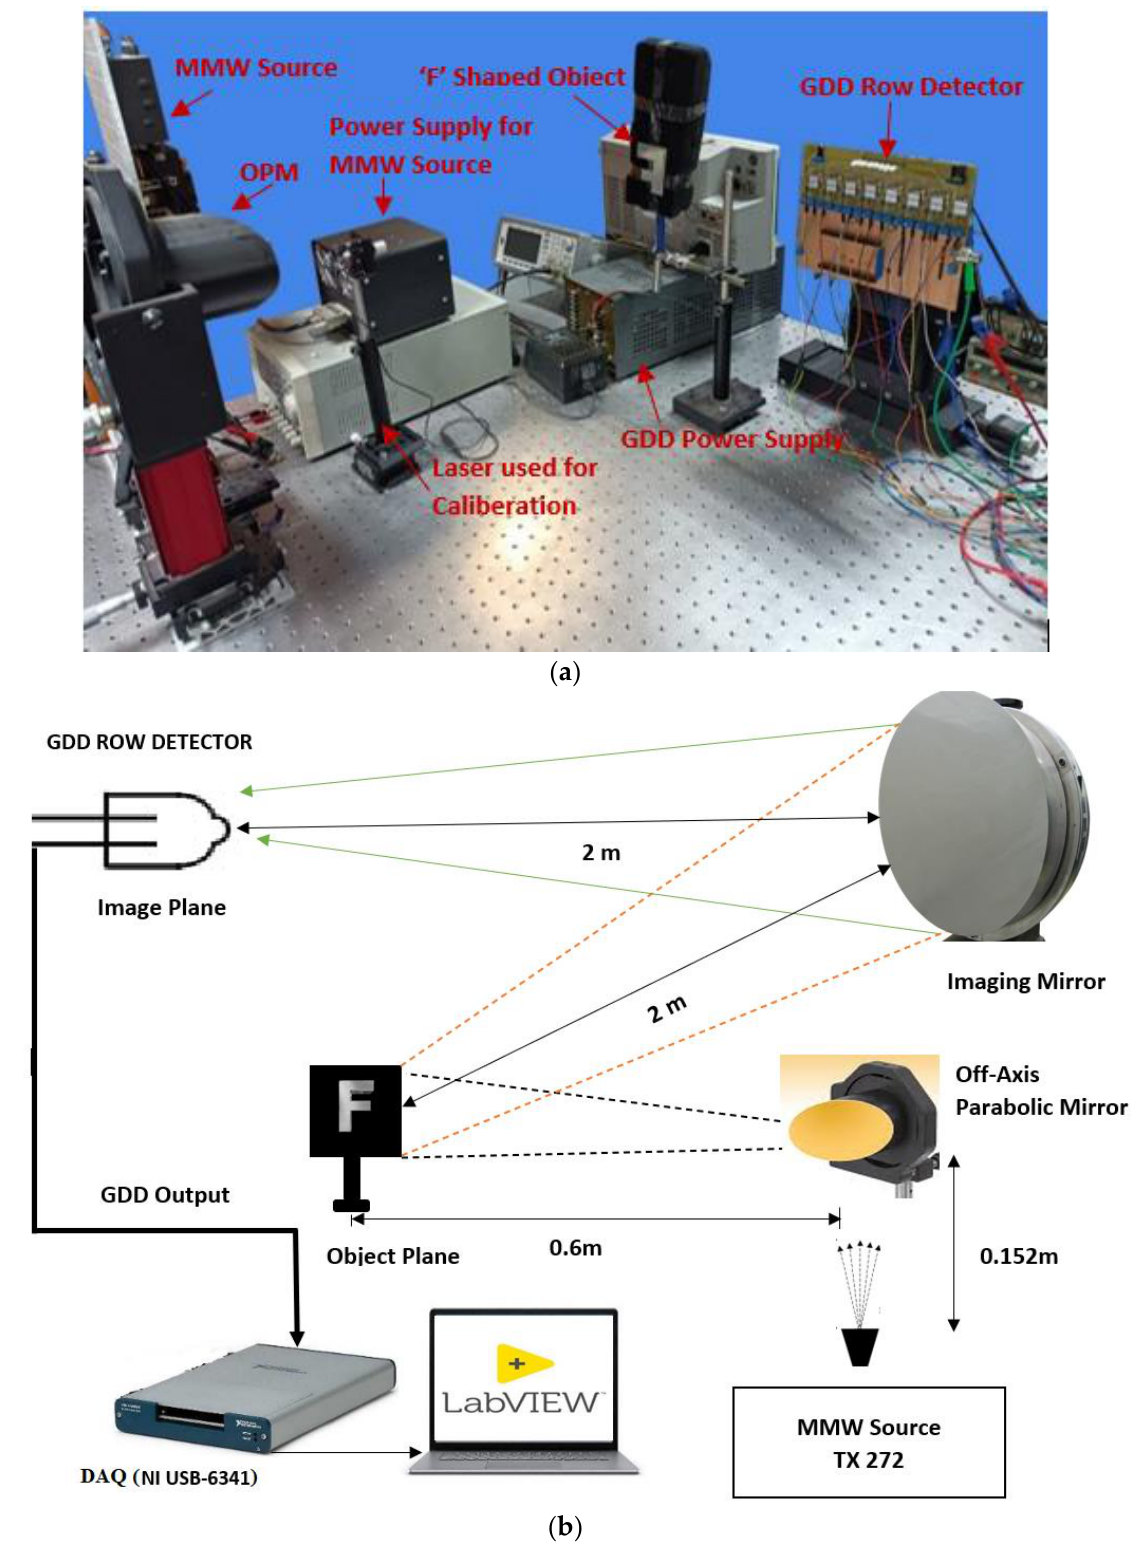
Figure 1. ( a ) Experimental setup of the MMW imaging system and ( b ) a schematic diagram of the system.